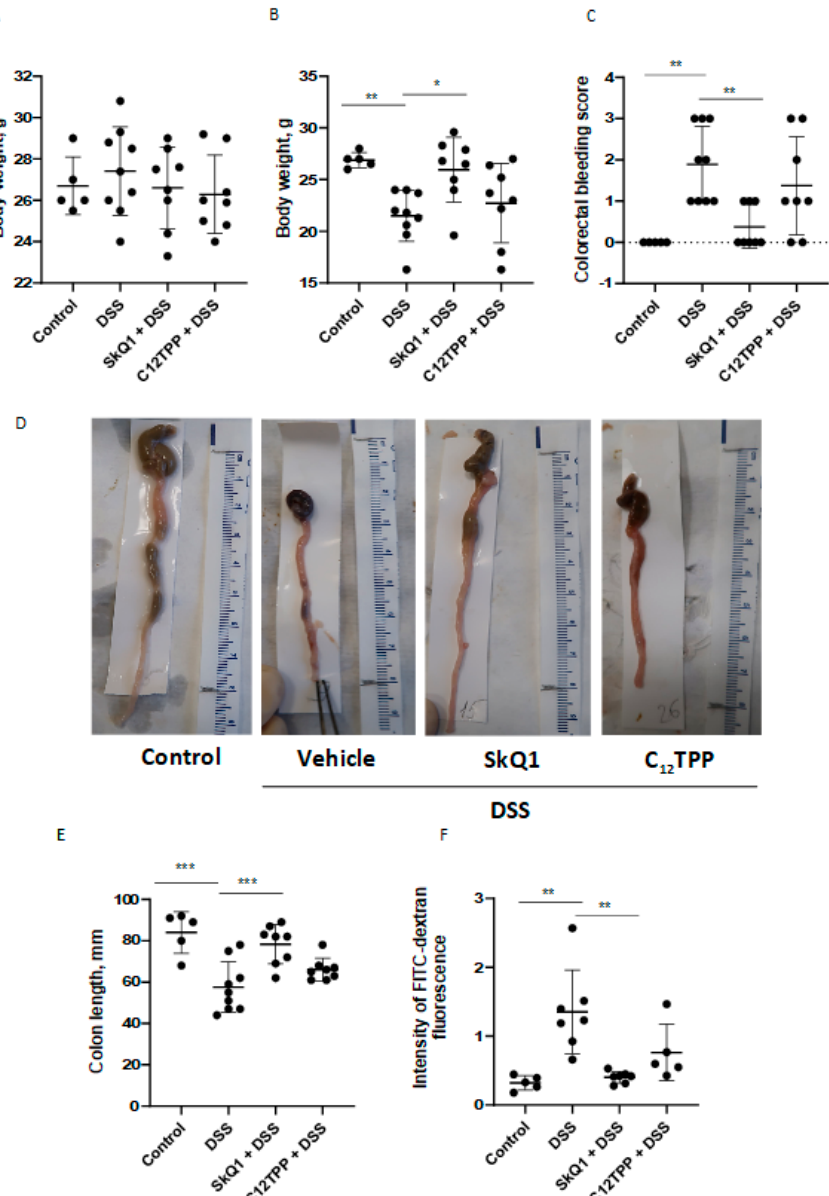
SkQ1. Treatment of mice by C 12 TPP, the analog of SkQ1 lacking the antioxidant quinone moiety, using the same scheme did not protect against colitis (Figure 1).